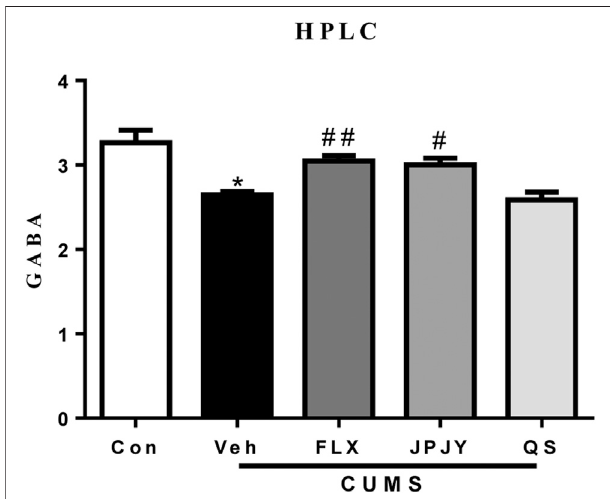
FIGURE 6 | The expressions of GABA in serum were reversed in mice exposed to chronic mild stress. Mice were exposed to chronic unpredictable mild stress (CUMS), and received treatment of Veh (Vehicle), FLX, JPJY and QS. Control (Con) mice were not exposed to stress but received vehicle treatment [F (4, 15) (cid:2) 9.628, p < 0.001].